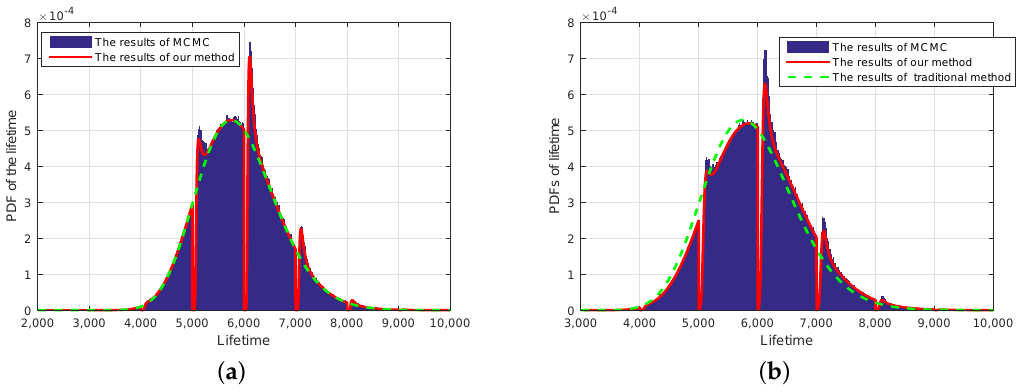
Figure 3. The comparison of lifetime estimation. ( a ) The comparison of PDFs with fixed jumps; ( b ) The comparison of PDFs with random jumps.